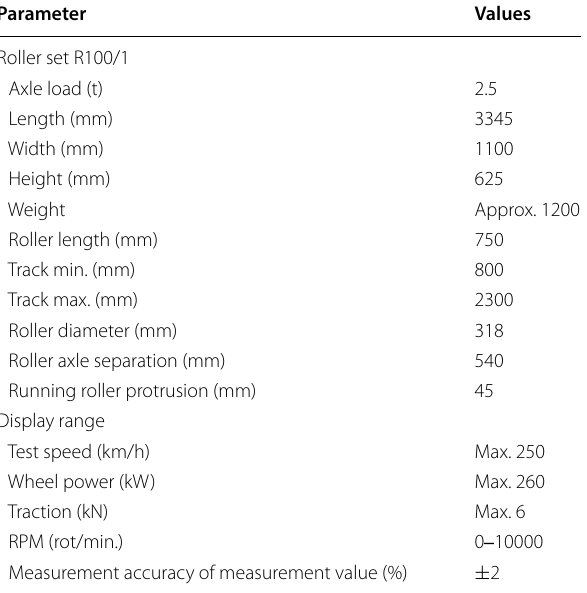
Table 5 Basic technical data of the Maha LPS 3000 dynamometer (Maha Manuals)